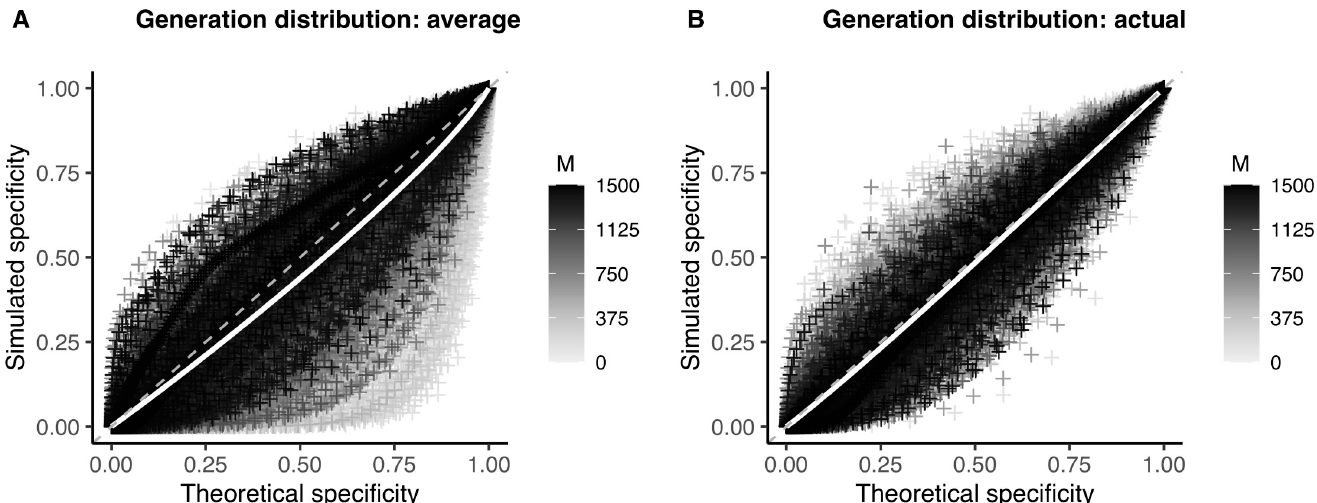
Fig 6. Effect of the generation distribution on specificity of the linkage criteria. Theoretical versus simulated specificity for each genetic distance threshold in 10,000 simulations of varying substitution rate and reproductive number (proportion sampled = 0.75). White line: smoothed conditional mean; grey dashed line: y = x line. Increasing values of the sample size ( M ) are plotted in darker color. ( A ) Theoretical sensitivity and specificity calculated using average distribution of generations between infections from simulations (see S2 Text ). ( B ) Theoretical sensitivity and specificity calculated using the actual distribution of generations between infections from that simulated